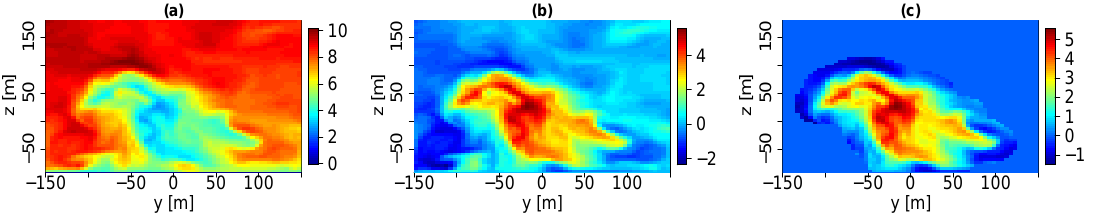
Figure 5. Preprocessing of the velocity field u ( ms − 1 ) : ( a ) Instant Snapshot t = 31.8 s; ( b ) Velocity deficit; ( c ) Extracted